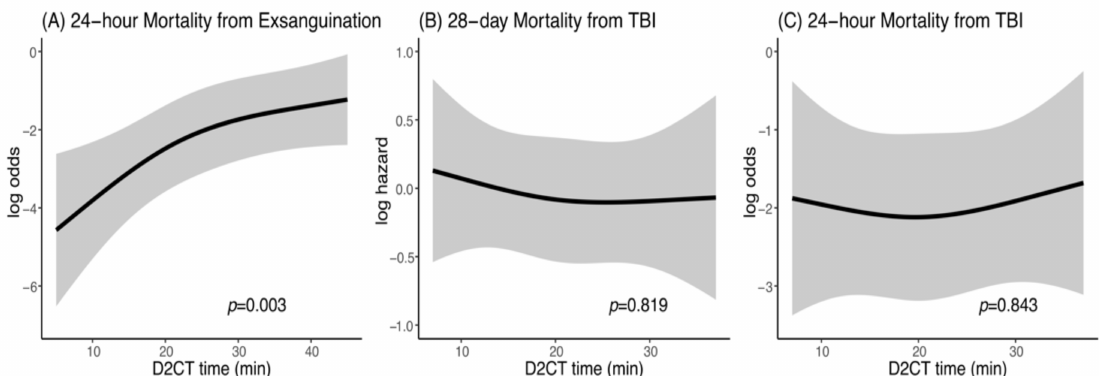
Figure 3. Effect of earlier D2CT on ( A ) 24-h mortality from exsanguination, ( B ) 28-day mortality from TBI, and ( C ) 24-h mortality from TBI. PH, proportional hazard; D2CT, door-to-CT; TBI, traumatic brain injury.